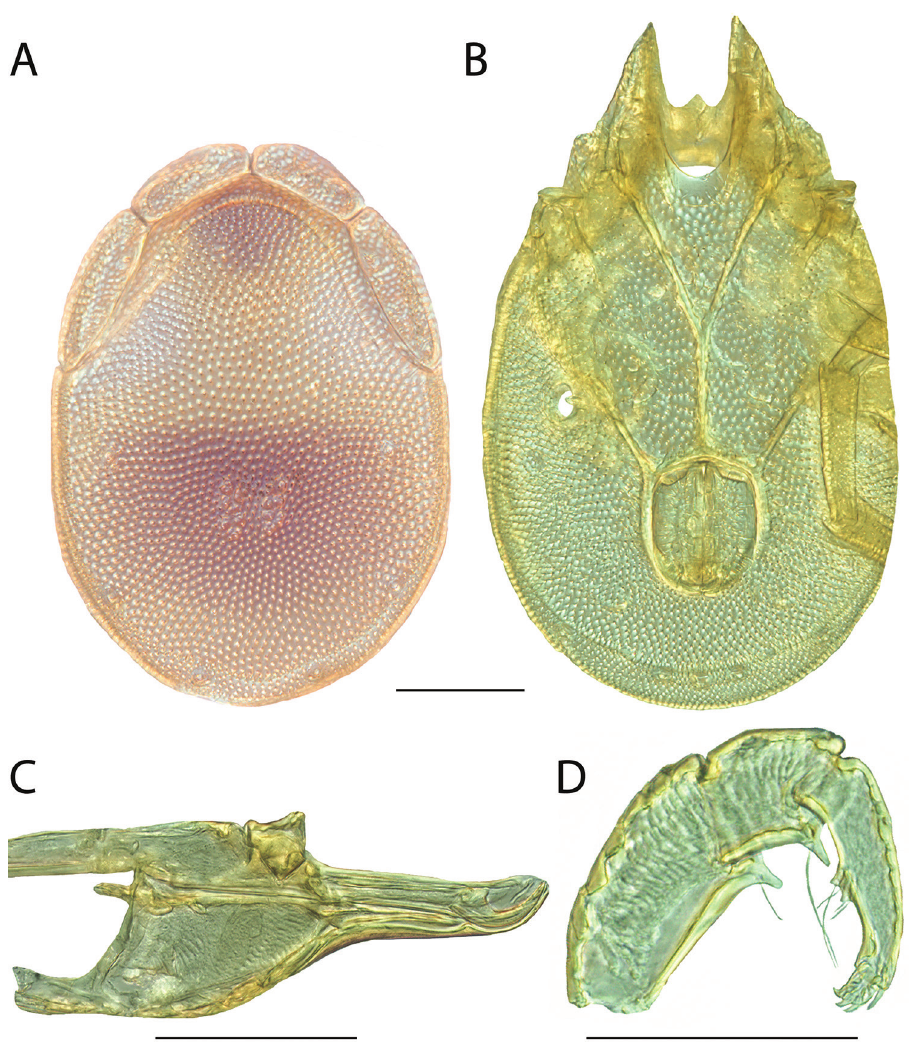
Figure 195. Torrenticola pollani sp. n. male: A dorsal plates B venter (legs removed) C subcapitulum D pedipalp (setae not accurately depicted). Scale = 100 µm. I mmatures